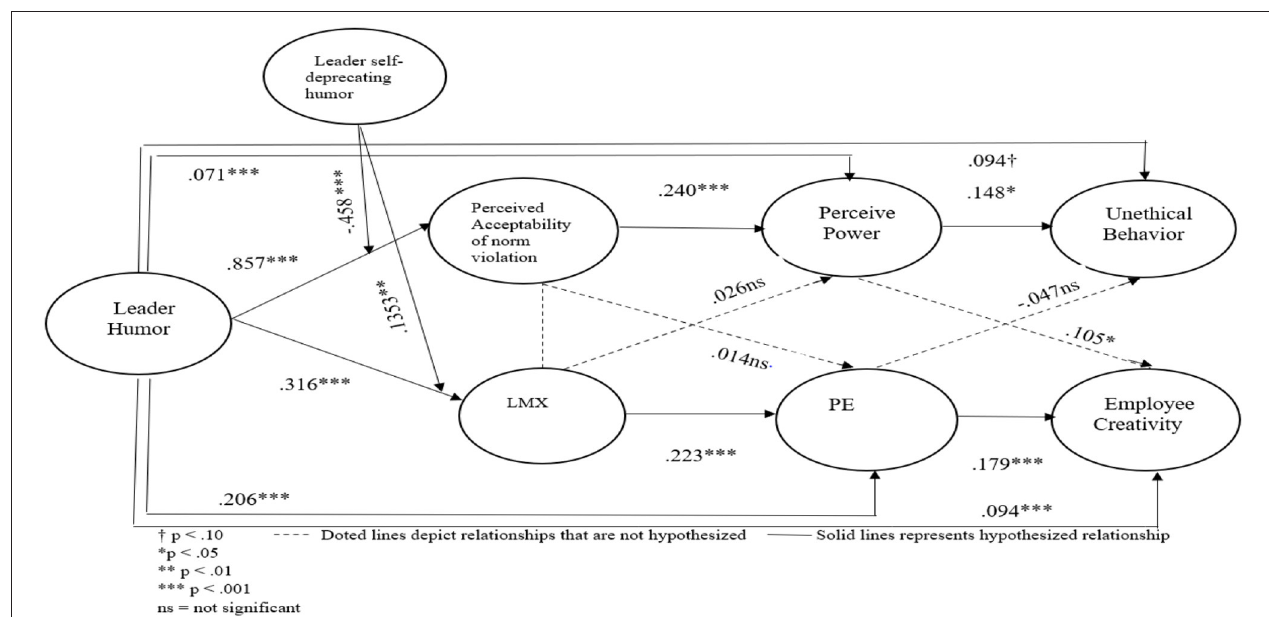
FIGURE 6 | Summarized results of paths models and hypotheses of current